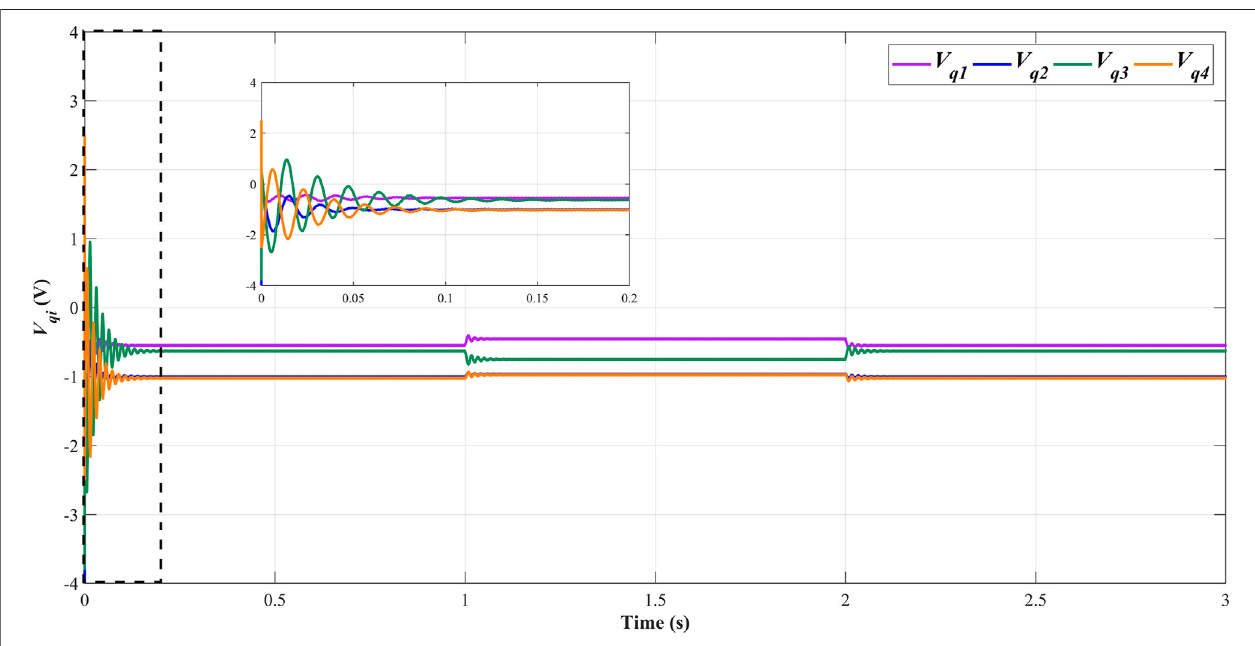
FIGURE 5 | Time evolution of the q -component of voltages of PCCs.